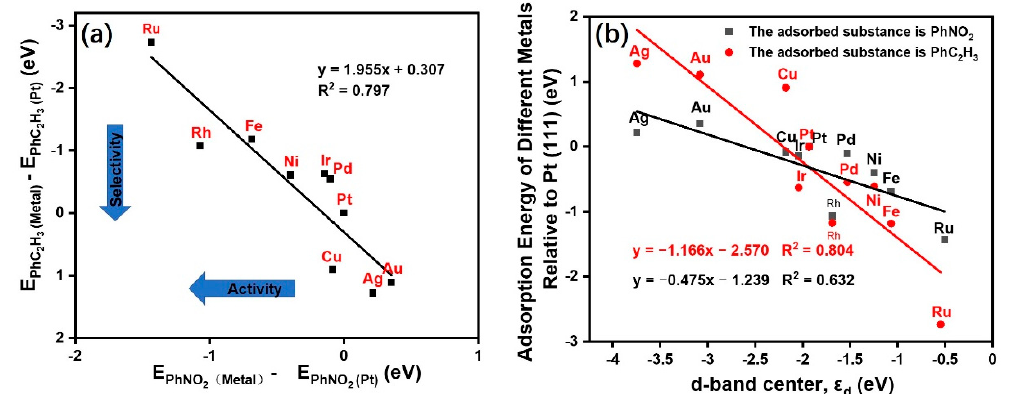
Figure 2. ( a ) The relative adsorption energies of PhNO 2 and PhC 2 H 3 on di ff erent transition metals, using Pt as the benchmark. Pt (111) is located at (0.0) (Table S2, SI), based on which the lower left region is the ideal region. ( b ) The adsorption energy trends for PhNO 2 and PhC 2 H 3 on di ff erent metals with the change of the d-band center positions of the metal surface